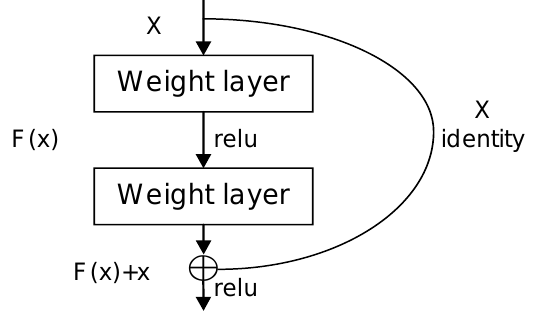
Figure 8. Residual neural architecture.